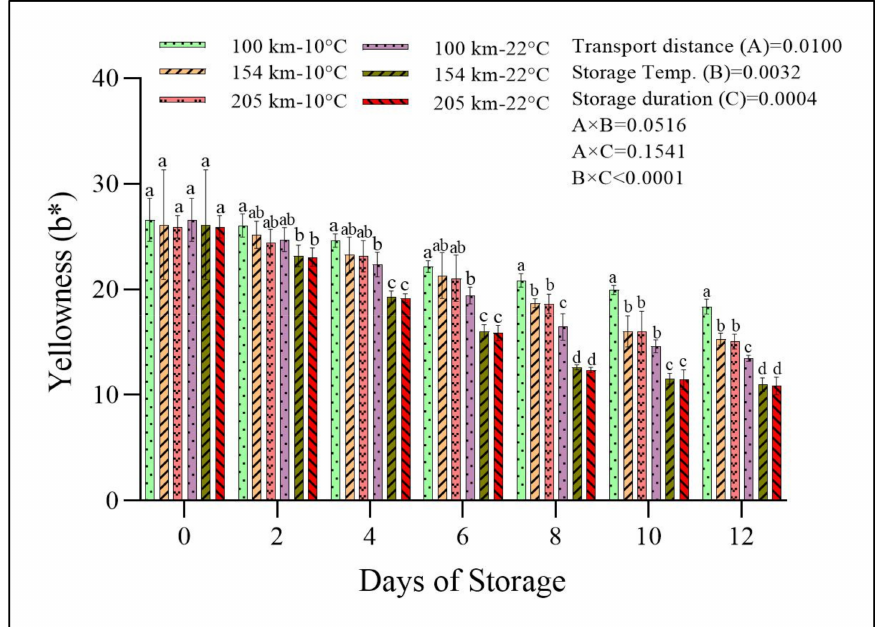
Figure 7. b* value of tomatoes from three different distances stored at (A) 10 ± 0.5 ◦ C (95 ± 1% RH) and (B) 22 ± 1 ◦ C (65 ± 5% RH) for 12 days. Error bars represent standard error (SE) of the mean values ± S.E. of 25 measurements (readings) of 5 tomato replicates. Bars with different letters (per day) are significantly different ( p < 0.05) performed by the Tukey HSD test and numerical values of A, B, and C are p